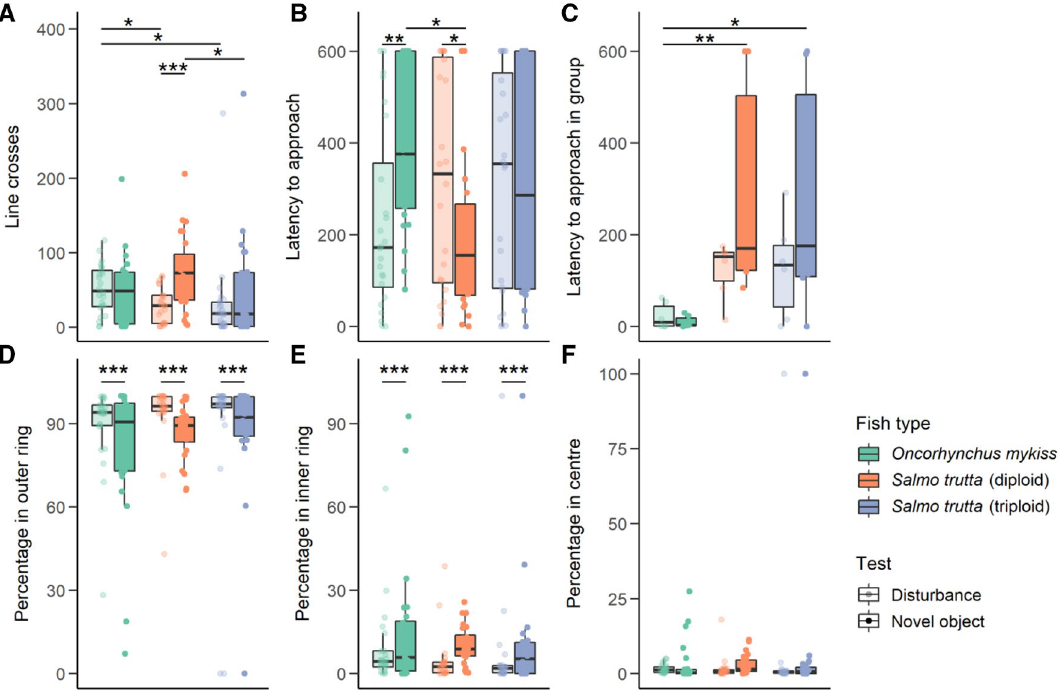
Figure 2. Boxplots showing the variables measured during the disturbance and novel object tests, including the group test, with median and interquartile range plotted and overlayed with raw data points. Asterisks show significance values (* p < 0.05, ** p < 0.01, *** p < 0.001). ( A ) Total number of line crosses, ( B ) the latency to begin swimming from the start of the recording in the individual tests, ( C ) the latency to begin swimming